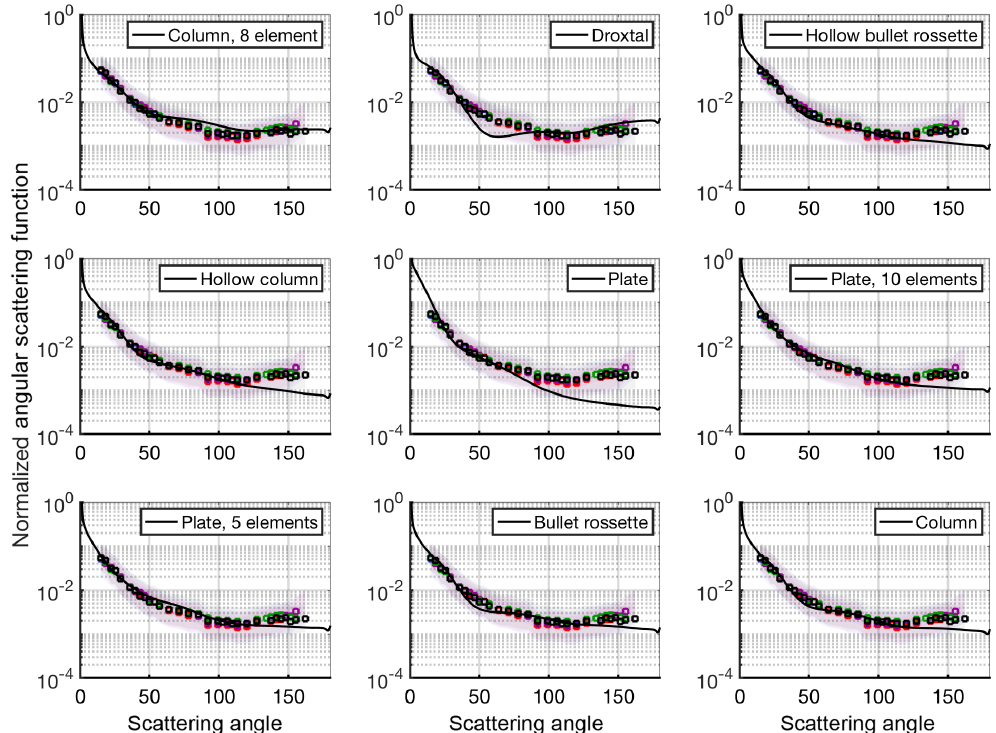
Figure 6. Same as Fig. 5 but now showing the comparison for PN measurements and for different optical models calculated for 804nm. All calculations were made assuming severely roughened surfaces. Both the measurements and the model results are normalized to the total intensity between 15 and 155 ◦